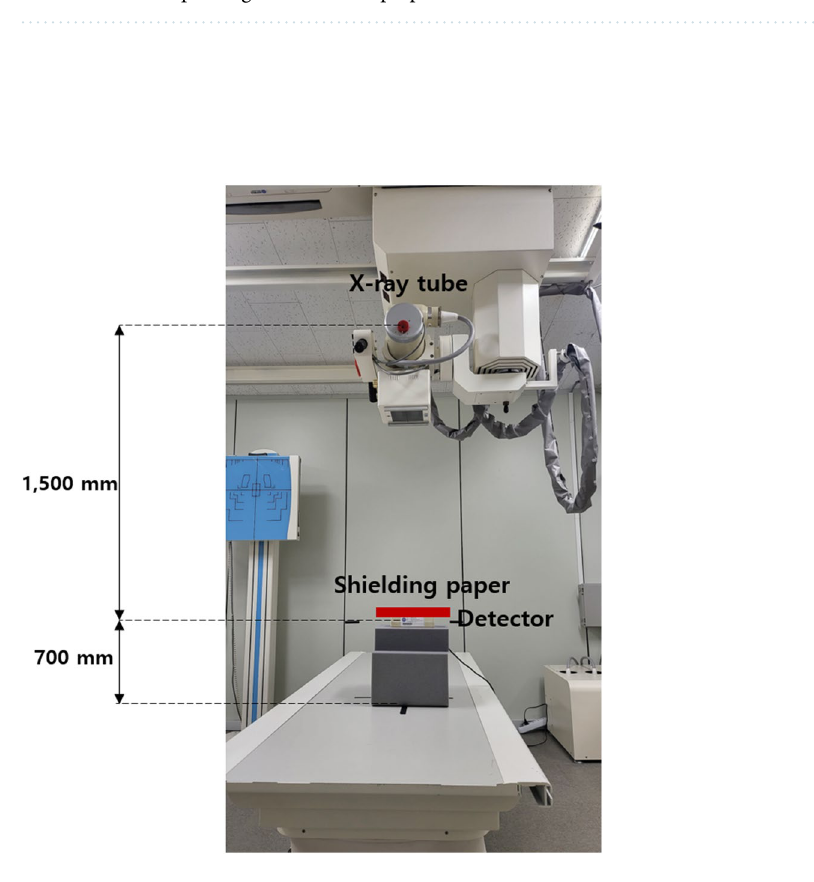
Figure 6. Experimental setup to evaluate the shielding performance of the shielding